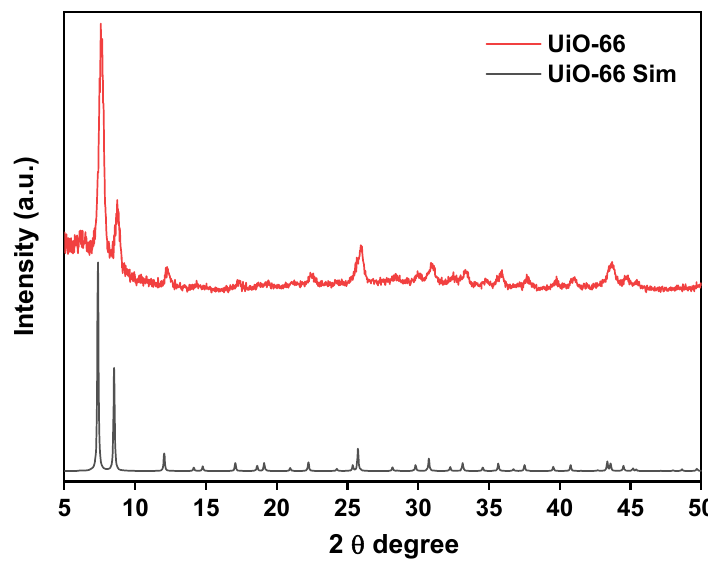
Figure 1. PXRD patterns of UiO ‐ 66.